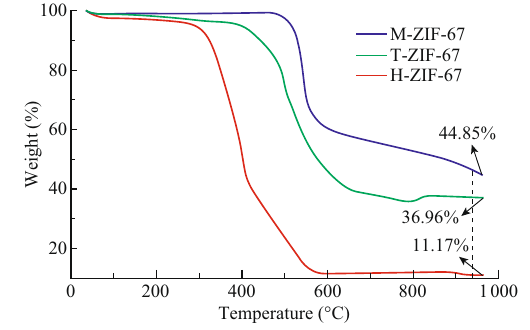
Fig. 6 TGA curves of M-ZIF-67, H-ZIF-67, and T-ZIF-67